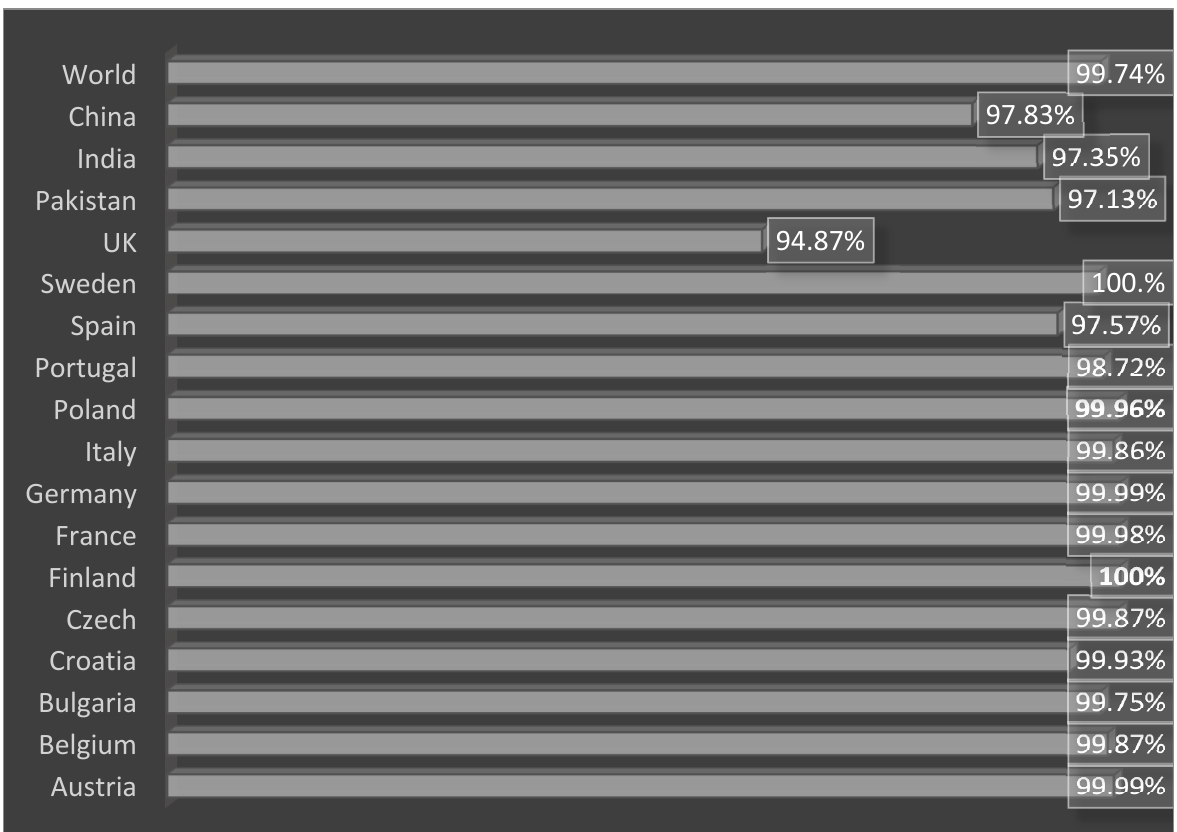
Figure 11. Population coverage percentages of the designed vaccine across different countries.